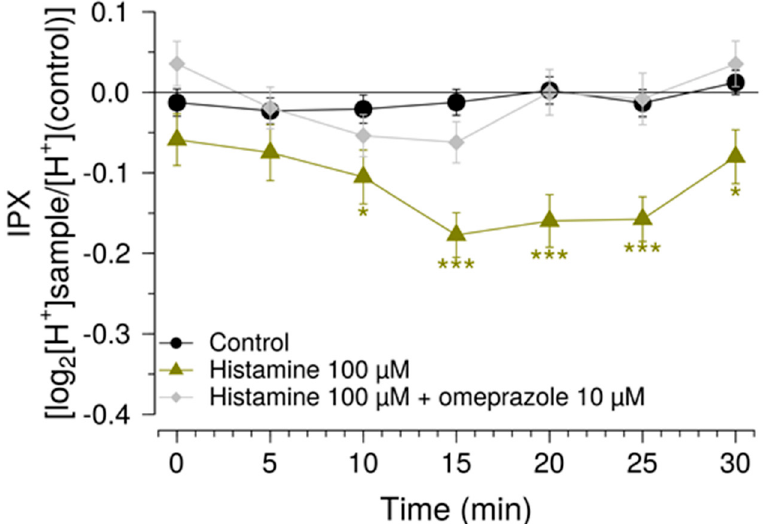
Figure 5. Effect of omeprazole on proton secretion by HGT-1 cells. Intracellular proton index (IPX) of HGT-1 cells exposed to 100 µM histamine alone (green triangles) or in combination with 10 µM omeprazole (grey diamonds). Recordings were performed at room temperature at intervals of 5 min. Cells treated with vehicle solution served as negative control (black circles). Data presented as mean ± SEM. Statistical significance was evaluated using one-way ANOVA with Tukey’s range test for multiple comparisons. * denotes p < 0.05 and *** denotes p < 0.001 for the corresponding compound, according to the assigned color when compared to the negative control. N of 6 BR, 12–24 TR.